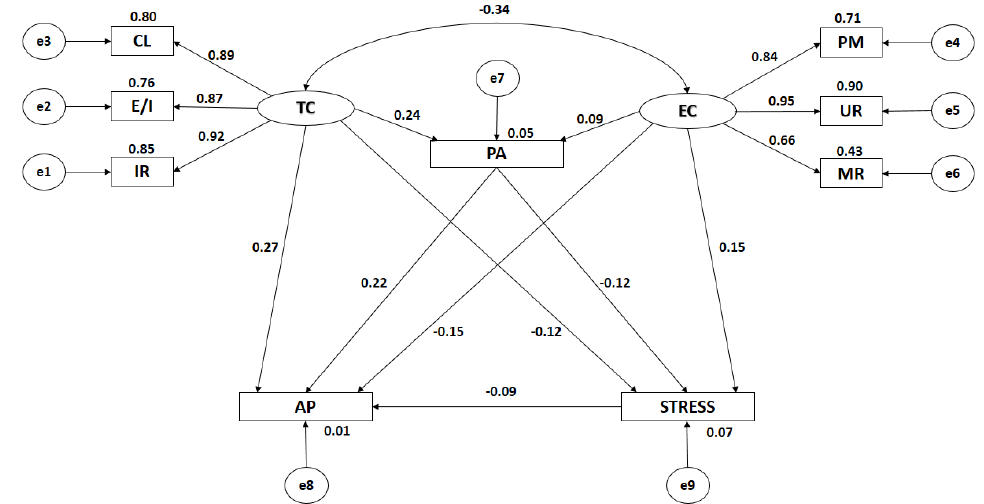
Figure 3. Structural equation model for females only. Note: TC, task climate; CL, cooperative learning; E/I, effort/improvement; IR, important role; EC, ego climate; MR, member rivalry; PM, punishment of mistakes; UR, unequal recognition; PA, physical activity; AP, academic performance; and STRESS, life stress. Table 2. Structural model for females. Associations between Variables